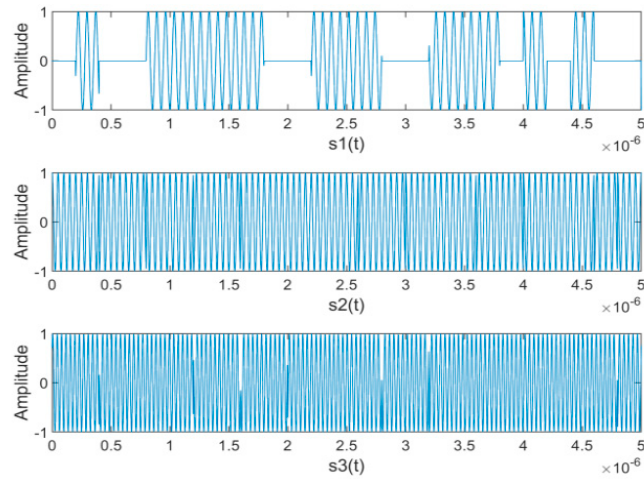
Figure 9. The waveforms of source signals.